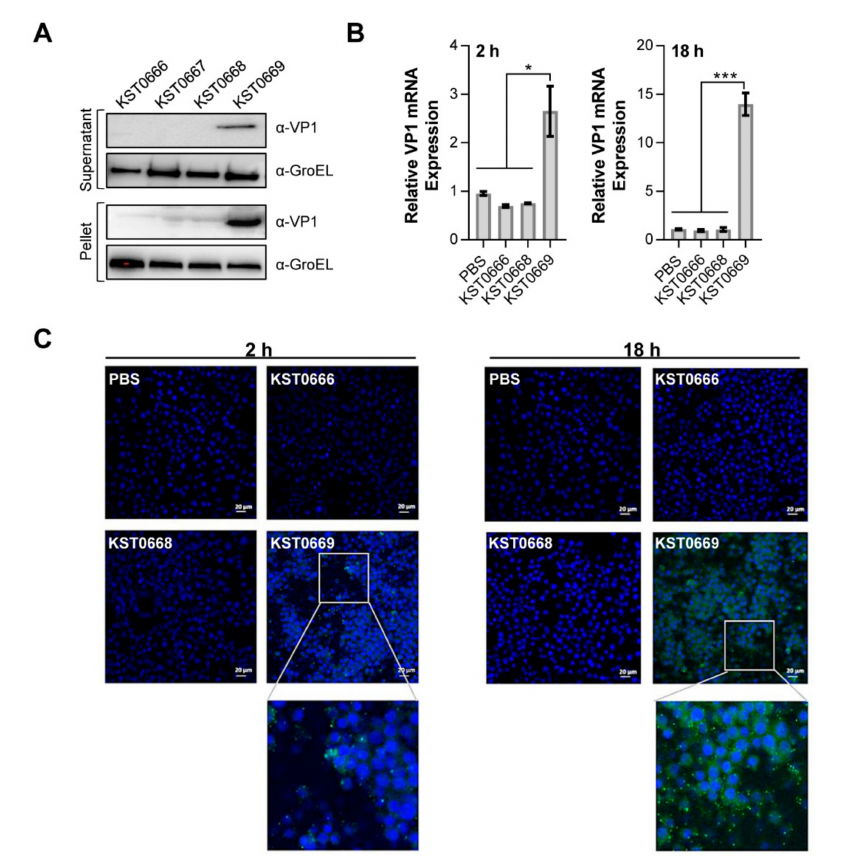
Figure 3. Expression of VP1 protein and mRNA in KST0669. ( A ) KST0666, KST0667, KST0668, or KST0669 were grown to mid-log phase and proteins were extracted from cell pellets and culture supernatants, after centrifugation. VP1 protein expression levels were measured with a rabbit anti-FMDV antibody and detected by western blotting. α -VP1: anti-VP1; α -GroEL: anti-GroEL. ( B ) VP1 mRNA expression levels in Salmonella -infected mouse macrophages. RAW264.7 cells (5 × 10 5 per well) were infected with KST0666, KST0668, or KST0669 (MOI = 10) and phosphate-buffered saline (PBS)-treated RAW264.7 cells were used as negative control. Total mRNA was isolated at 2 and 18 h post-infection, and VP1-specific mRNA levels were measured using RT-qPCR. Data are expressed as mean ± SEM per group and analyzed by t test. *** p < 0.005, * p < 0.05. ( C ) Visualization of VP1 protein expression in Salmonella -infected RAW264.7 cells at 2 and 18 h post-infection. RAW264.7 cells (5 × 10 5 per well) were infected with KST0666, KST0668, or KST0669 (MOI = 10). Cell nuclei were stained with DAPI (blue), and VP1 protein (green) was detected with rabbit anti-FMDV IgG and FITC-conjugated goat anti-rabbit